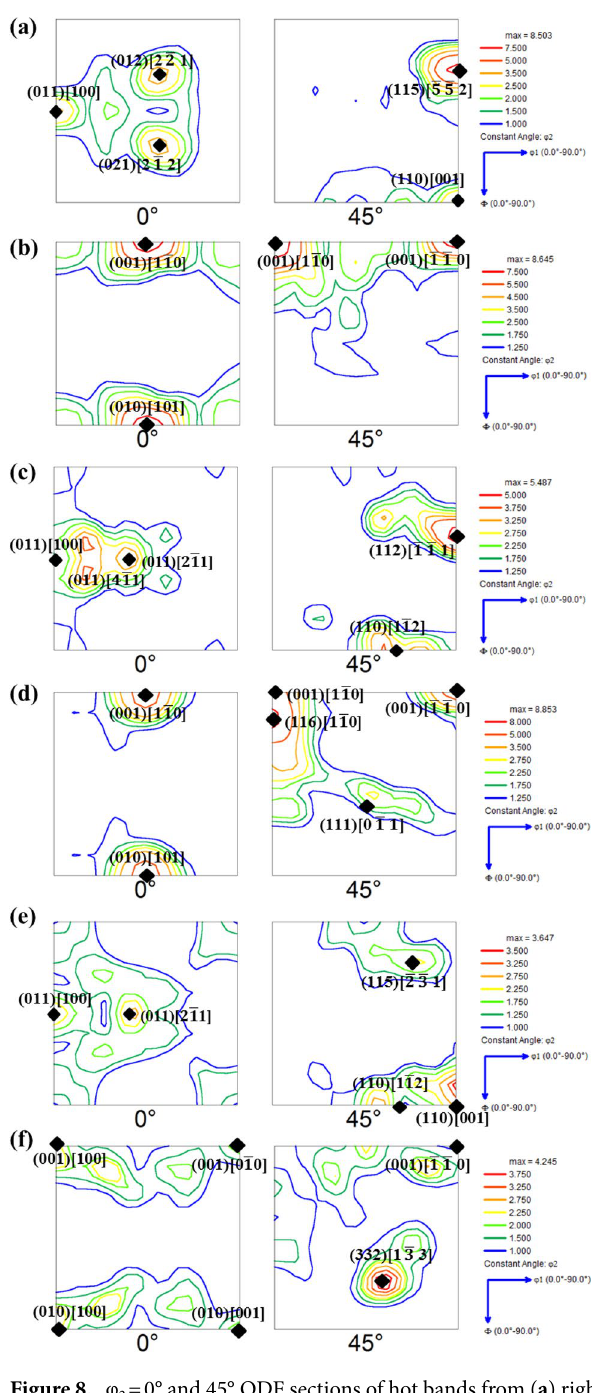
Figure 8. φ 2 = 0° and 45° ODF sections of hot bands from ( a ) right surface of Cast 3; ( b ) center of Cast 3; ( c ) surface of Cast 4; ( d ) center of Cast 4; ( e ) surface of Cast 5 and ( f ) center of Cast